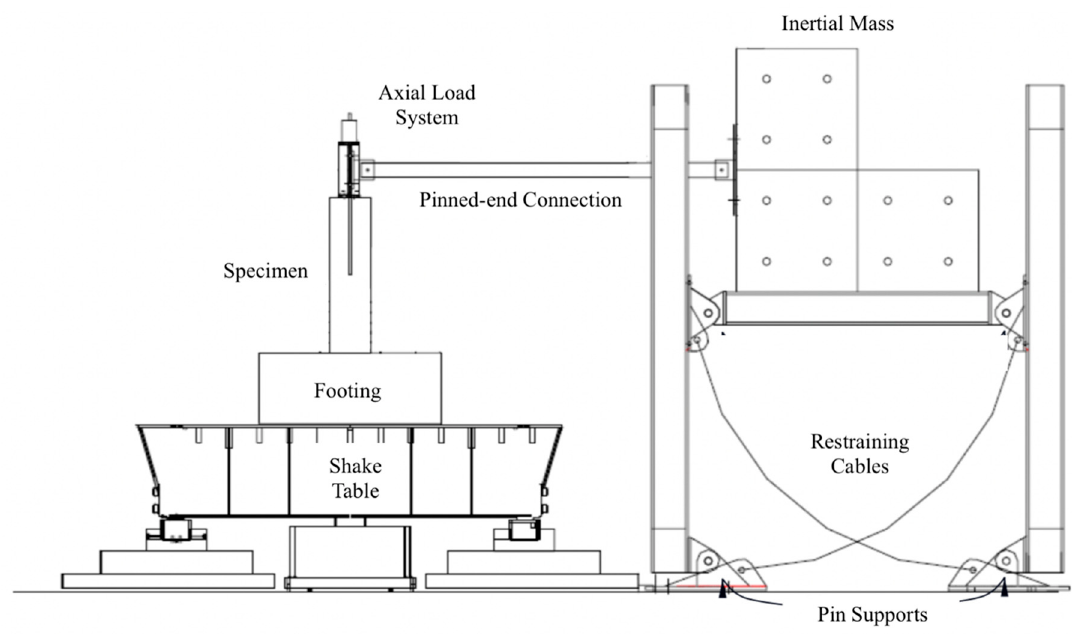
Figure 4. Adapted representation of a rotational system for supporting additional inertial mass.